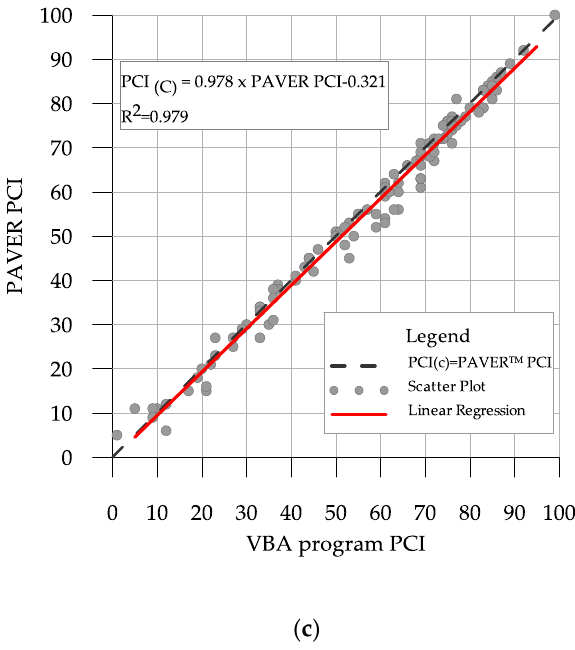
Figure 7. Regressions on 109 SU between PAVER TM PCI and calculated PCI using VBA program. ( a ) ASTM D6433 (20 distresses); ( b ) New merged distress identification catalogue (10 distresses); ( c ) New distress identification catalogue including two new distress definitions (11. Manholes and 12. Tree roots ). Table 6. Statistical parameters of automated procedure PCI calculation (ANOVA F-test).